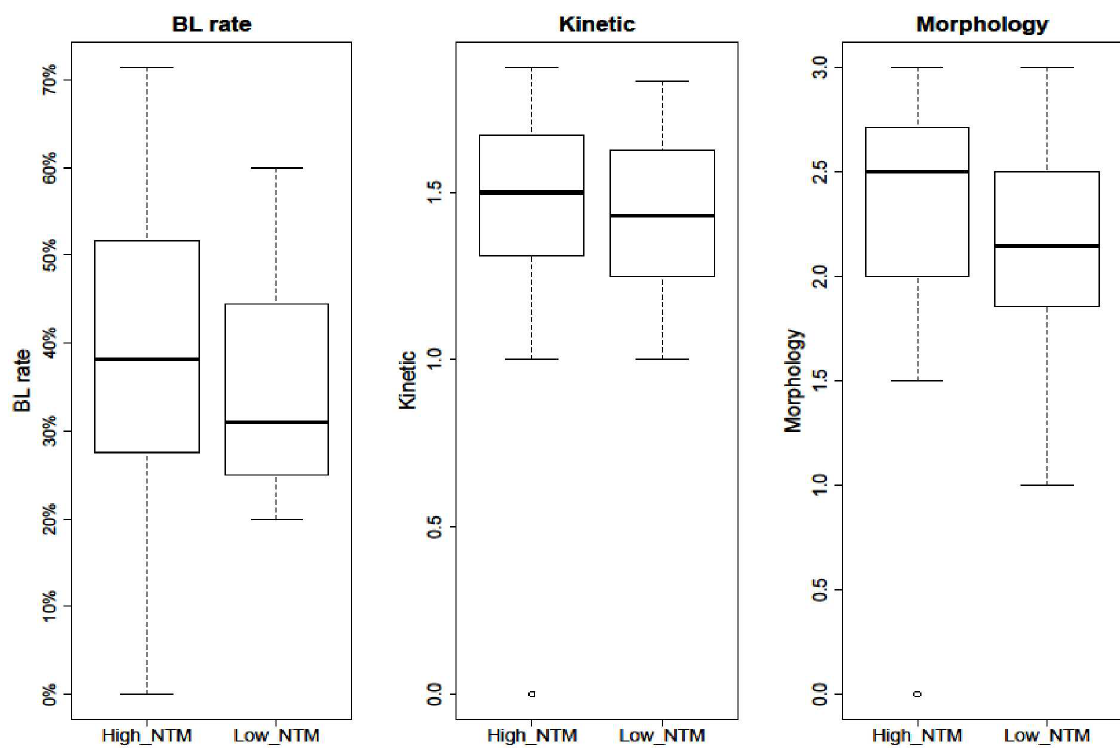
Fig 1. Box plots representing the differences in the distribution of IVP scores between samples inseminated with high- NTM and low-NTM index bulls. The thick line represents the medianvalues. The box represents the lower and upper quartiles. The thin lines are the maximum and minimumvalues excludingoutliers. Outliers are representedby empty